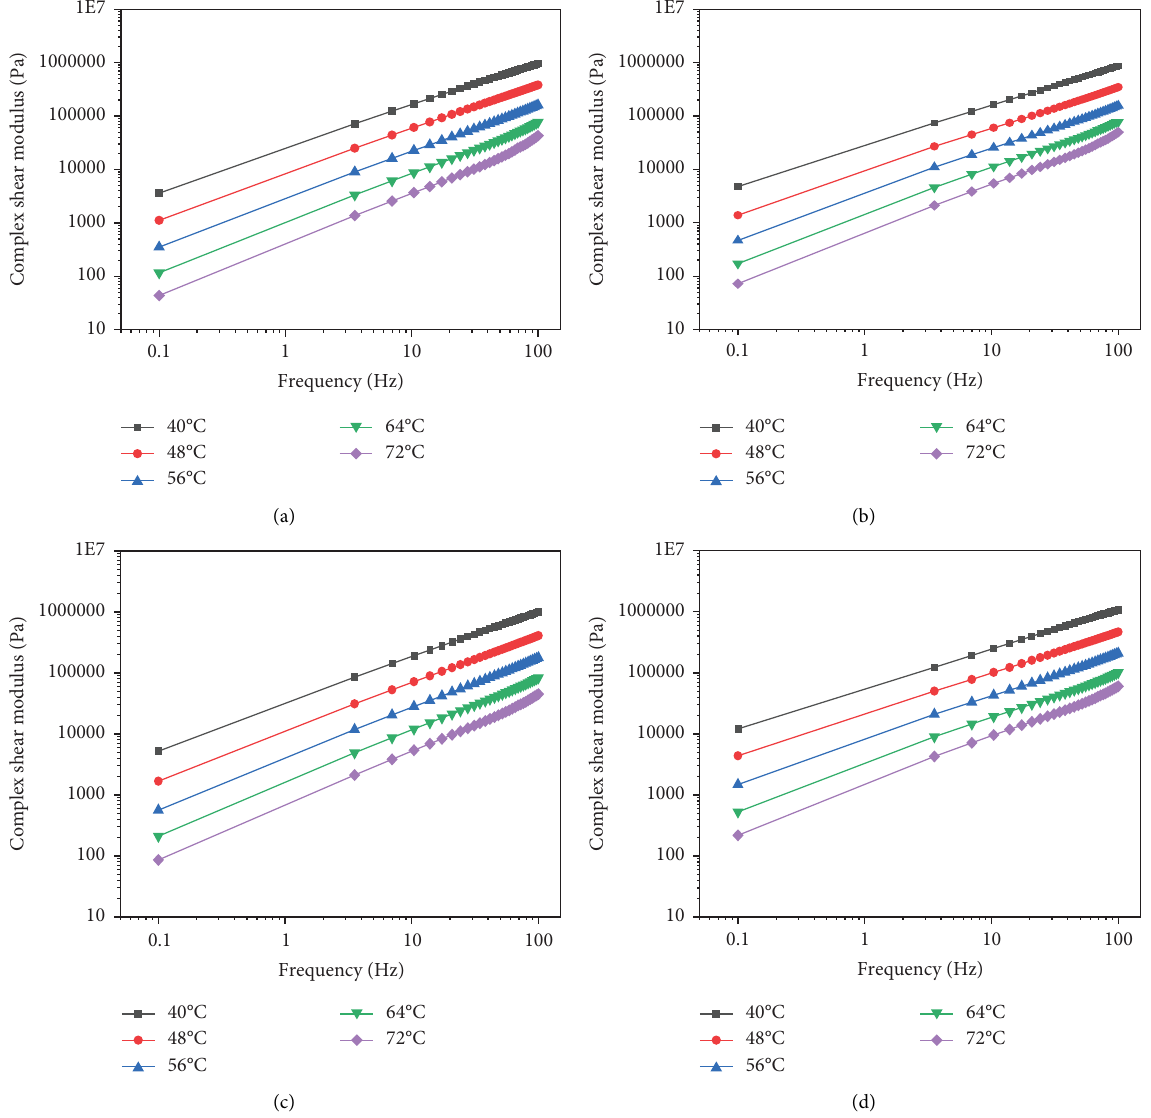
Figure 8: Variation of complex shear modulus with frequency for four types of emulsifed asphalt. (a) Base emulsifed asphalt. (b) 1.5% SBS modifed emulsifed asphalt. (c) 3% SBR modifed emulsifed asphalt. (d) SBS/SBR modifed emulsifed